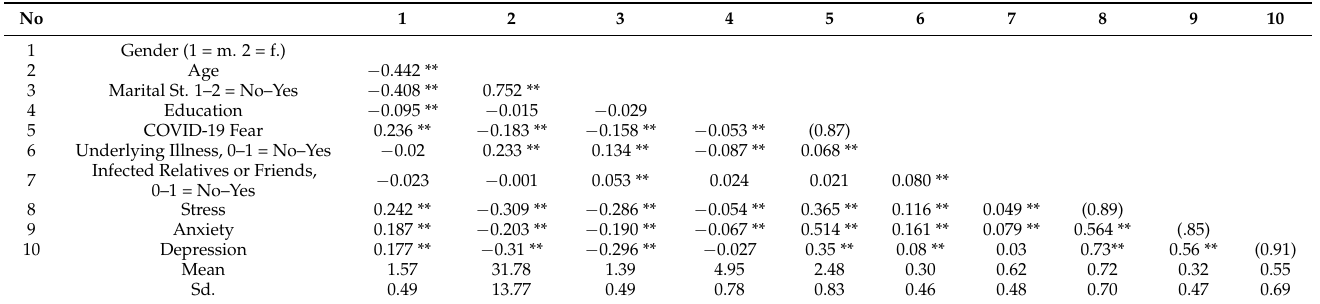
Table 2. Means, Standard Deviations, Reliabilities, and Correlations.